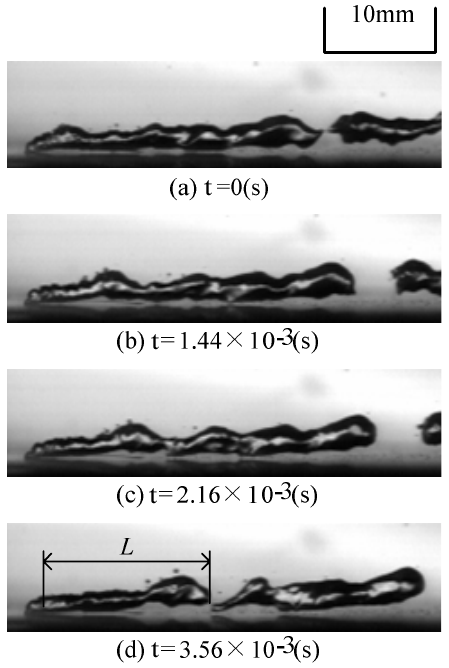
Fig. 8 Process of bubble growth and separation from the continuous jet (Rayleigh